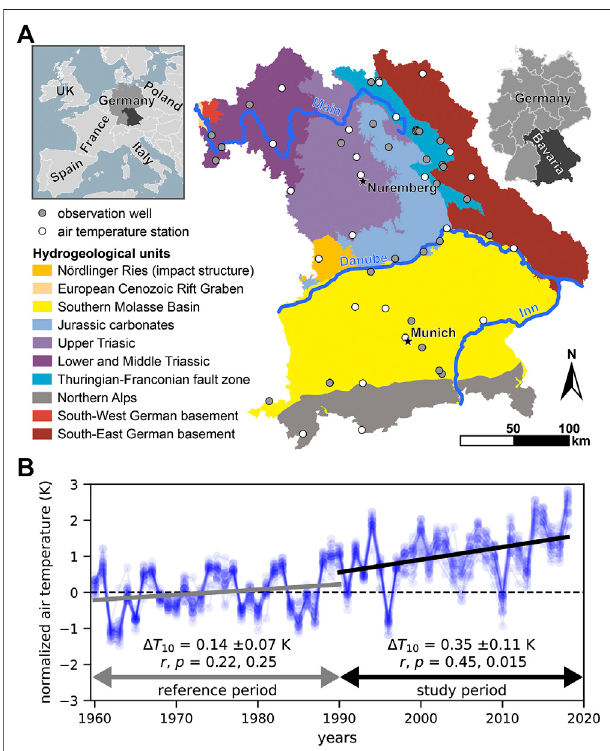
FIGURE1|(A) Mapofthemainhydrogeologicalunitsandthelocationof the 32 groundwater temperature (GWT) observation wells and the 23 air temperature (AT) stations selected for this study. Major cities and rivers are indicated by black stars and blue lines, accordingly. (B) Arithmetic annual mean air temperatures from 1960 to 2018 for 23 stations in Bavaria (blue dots and lines). Temperatures are normalized to the respective mean temperature of the period from 1960 to 1989 for each station. Δ T 10 is the decadal temperature change calculated by a linear least square regression with the Pearson correlation coef fi cient (r) and p -value